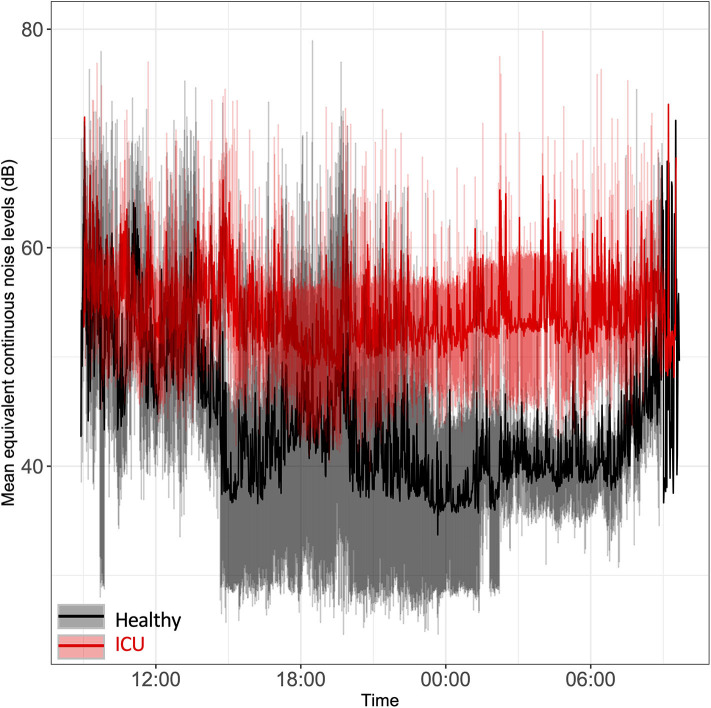
Time series plot of the mean equivalent continuous noise levels. Bedside noise levels were recorded in the rooms of ICU patients (red line) and healthy controls (black line). Light red shading represents the standard deviation for ICU patients; gray shading represents the standard deviation for healthy controls.